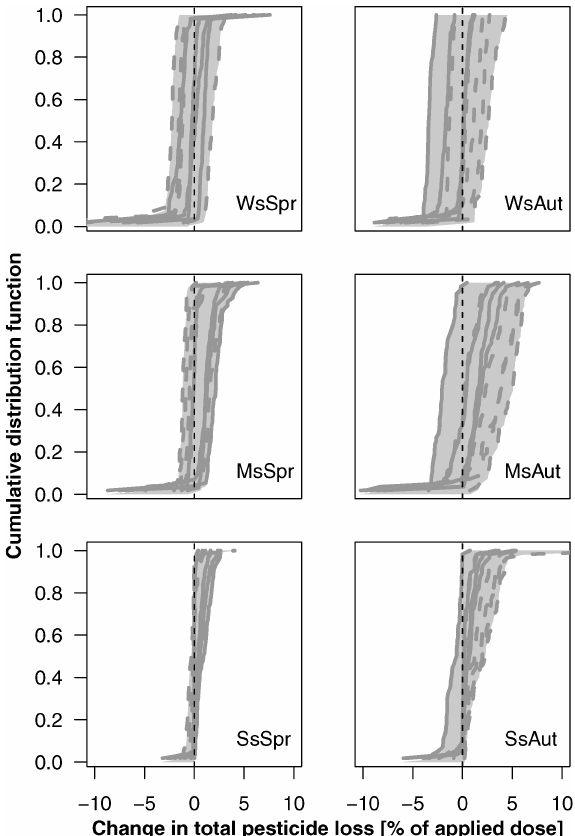
Fig. 5. Cumulative distribution functions for the predicted changes in pesticide leaching losses for the different climate scenarios (grey lines) as generated by 56 different parameterizations of the pesticide fate model. The pesticide application scenarios are abbreviated ac- cording to Table 3. The black dashed line represents a zero change in pesticide loss.